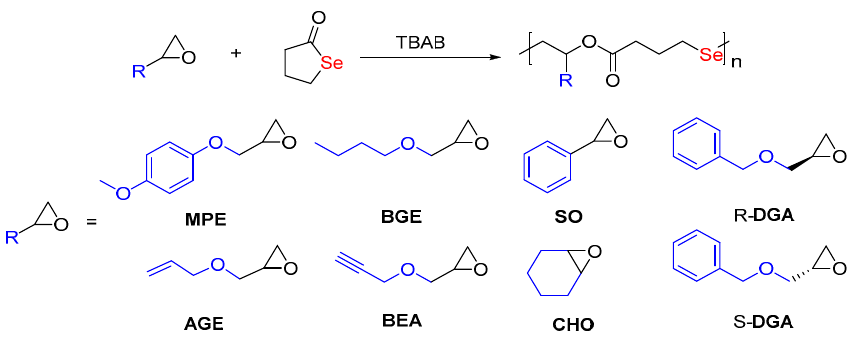
Table 2. Copolymerization of various oxiranes with SBL a .